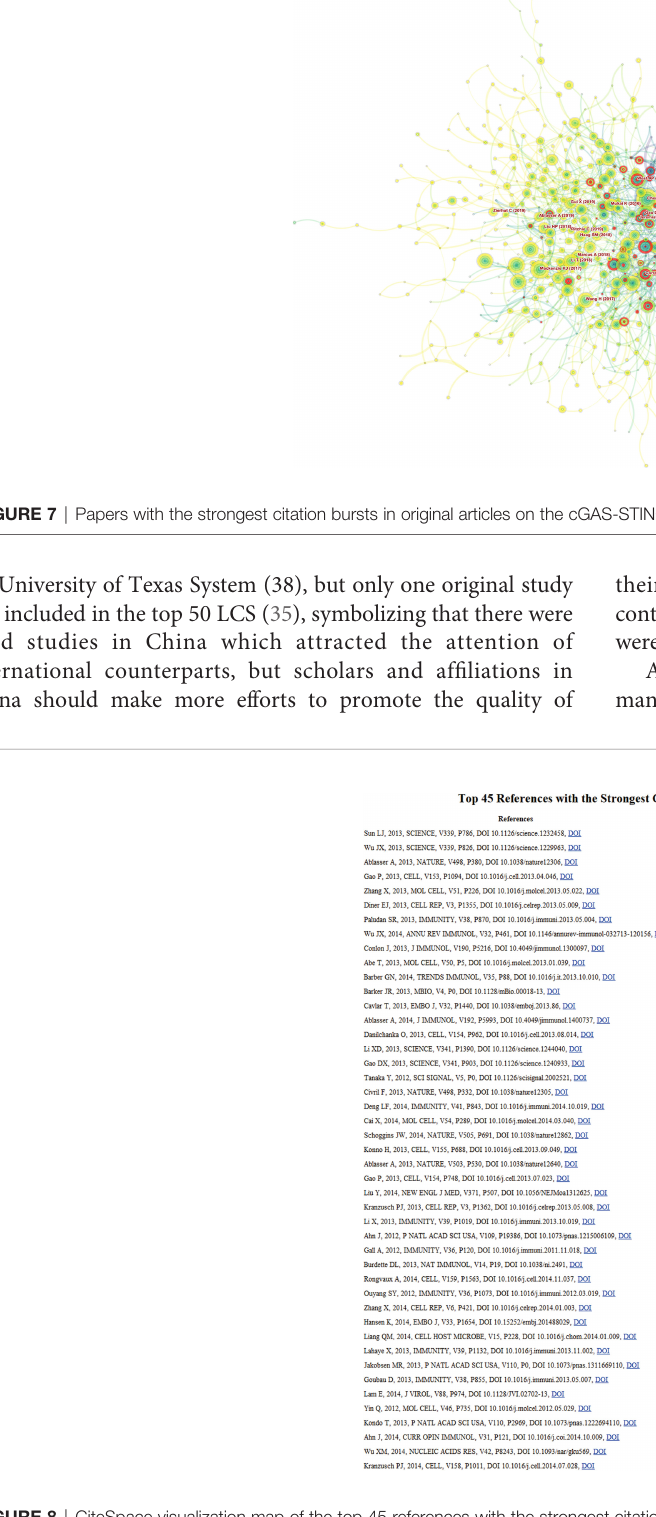
FIGURE 8 | CiteSpace visualization map of the top 45 references with the strongest citation bursts involved in the cGAS-STING